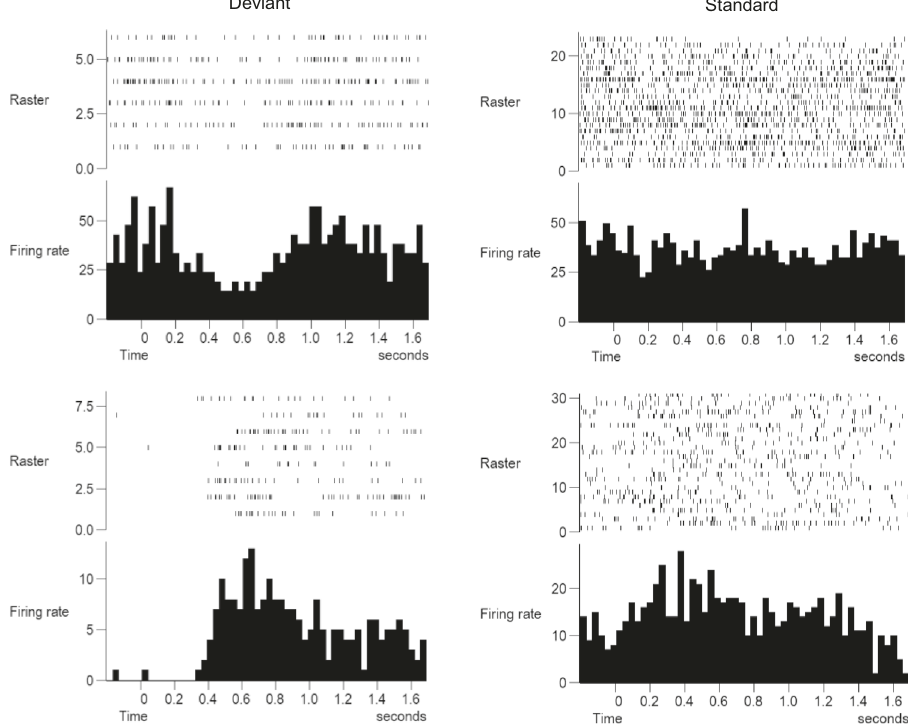
Fig. 2 Peristimulus time histogram of responses to the attended and unattended tones. An example of different responses to the auditory oddball task. In most neurons, there was a decrease in the fi ring rates during the deviant tones whereas no change was seen to the standard tones ( top-panel ). Some neurons showed an increase in fi ring rates ( bottom panel ). This increase was selective to the deviant tones that patients were asked to